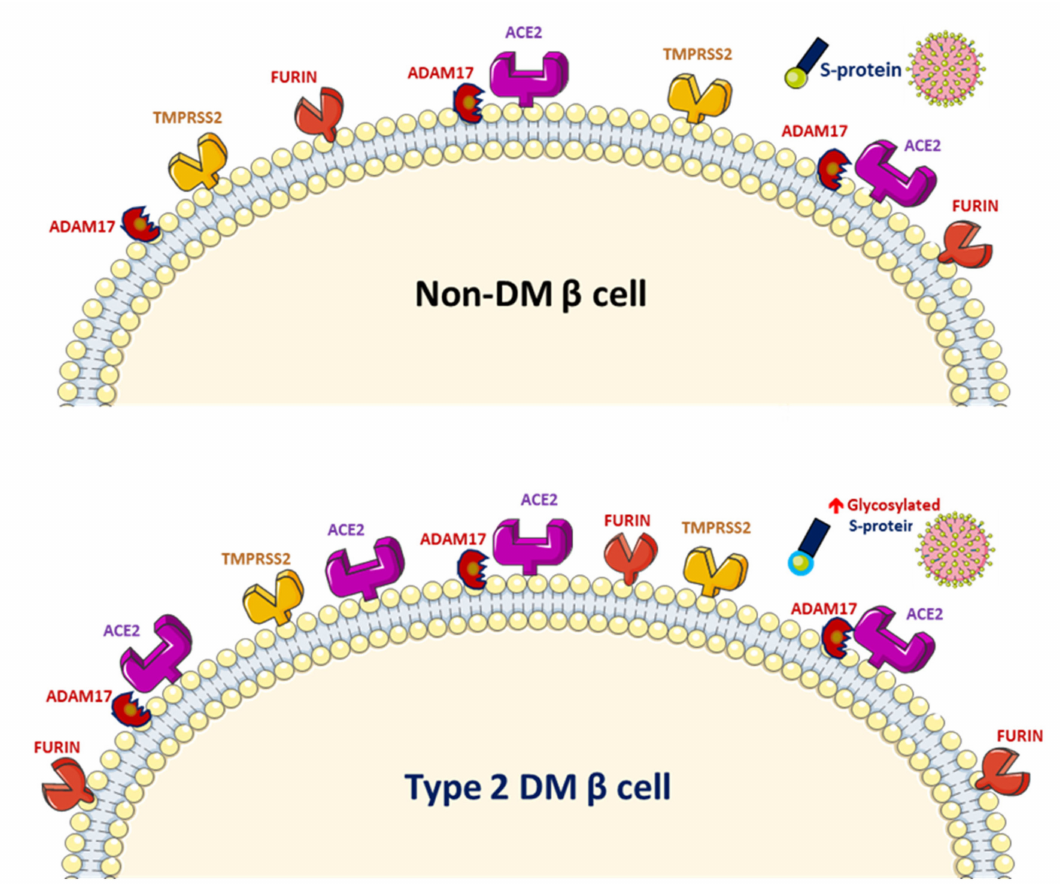
Figure 2. Increased glycosylated ACE2, ADAM17 and TMPRSS2 expression in human pancreatic islets and glycated SARS-CoV-2 spike protein in patients with diabetes mellitus